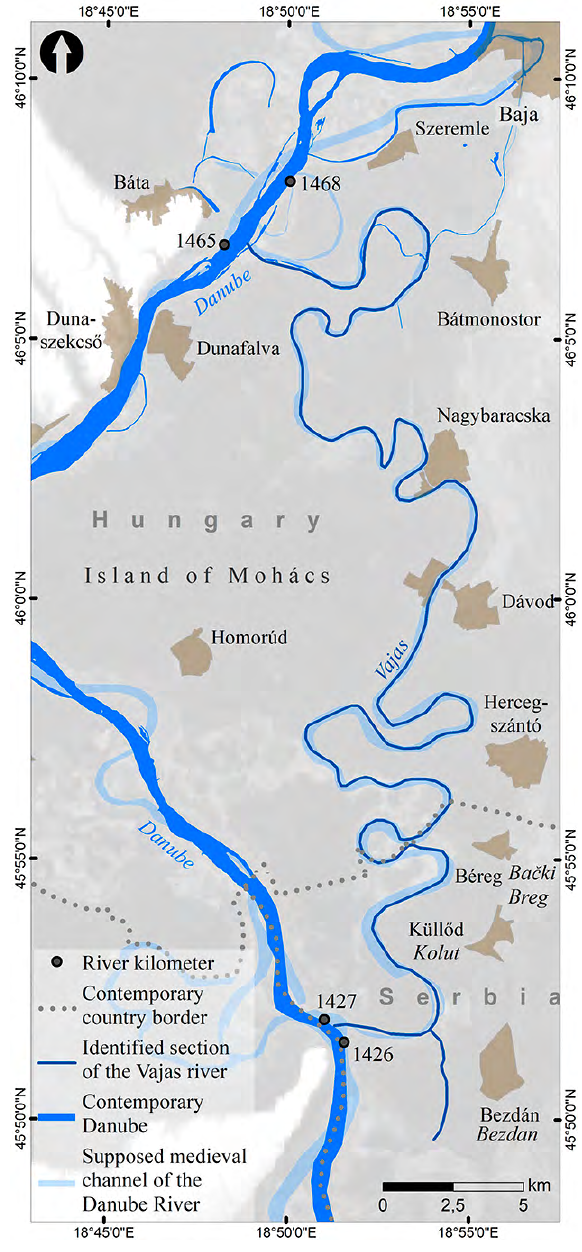
Figure 4. The channel of the Vajas